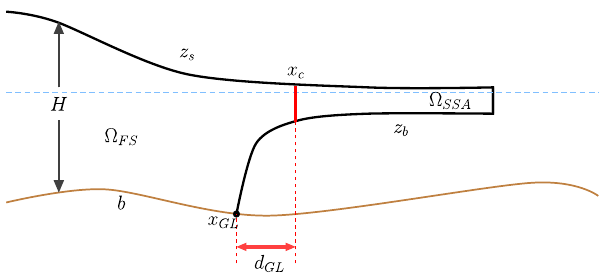
Figure 1. Overview of the notations and domain decomposition for a conceptual marine ice sheet. The vertical scale is exaggerated. The sea level at z = 0 is dashed blue and the interface between the FS and SSA domains is solid red. The bed elevation is denoted by b , the coupling interface by x c , and the grounding line by x GL . The distance between x c and x GL , defined in Eq. (17), is denoted by d GL